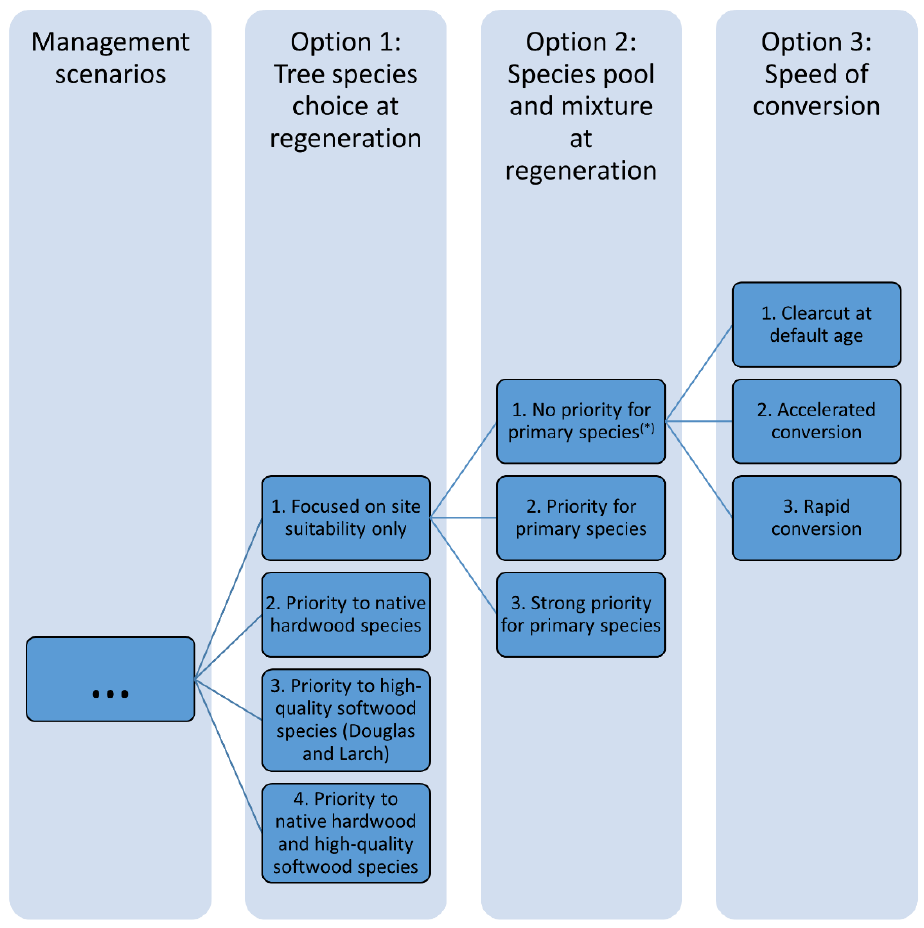
Figure 2. Overview of the hierarchical structure in management options for